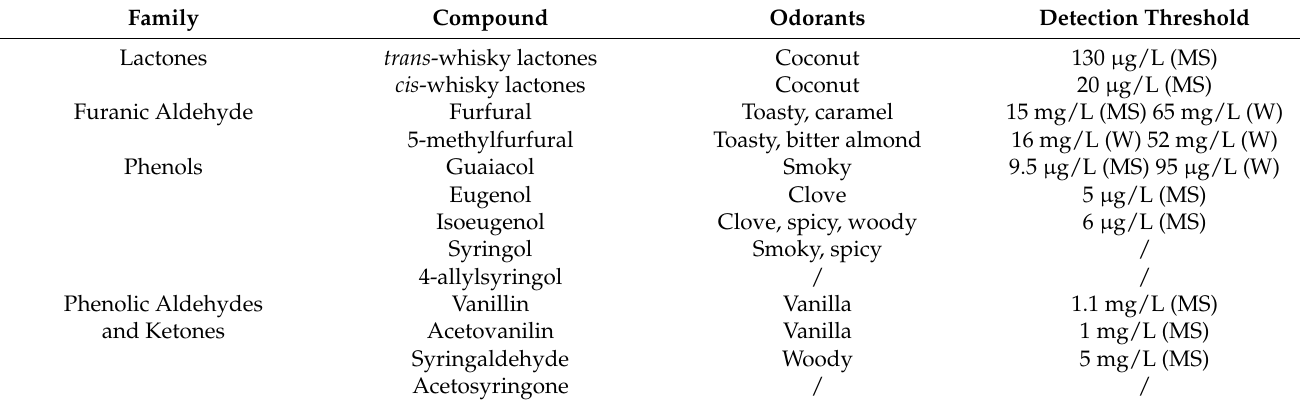
Figure 4. Oak wood volatile composition of red wines aging for 2, 4, 8, and 12 months in barrels of 1, 2, or 3 years cleaned with HPU hw or steam. (*) significant at p < 0.05; (**) significant at p < 0.01; (***) significant at p < 0.001. Table 2. Volatile compounds present in oak wood and their detection threshold